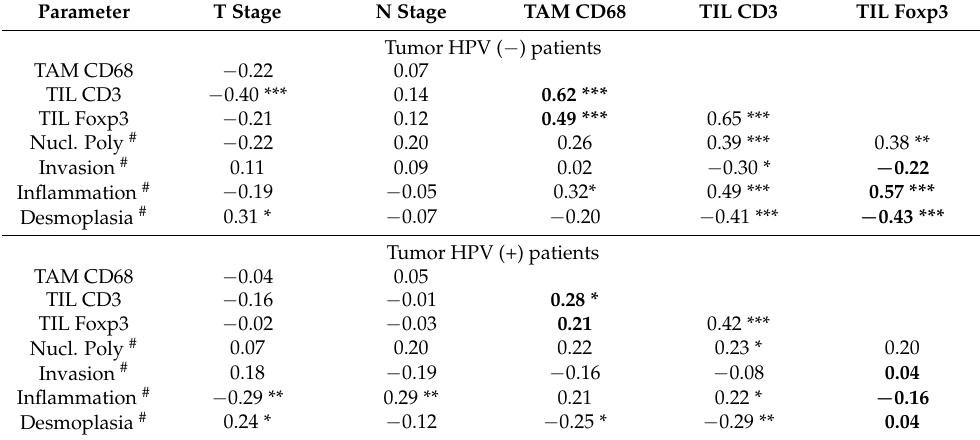
Figure 2. Cell type levels in tumors by HPV status, determined by PCR. Abbreviations: TAM: Tumor- associated macrophages (CD68 (+) cells). TIL: Tumor-infiltrating lymphocytes (CD3 (+)/Foxp3 (+) cells. These parameters determined by immunohistochemistry. Statistics by student t -test: CD68: p = 0.072; CD68-ln: p = 0.024. CD3: p < 0.001. Foxp3: p = 0.001. Y -axis: number of positive cells per HPF at 630x magnification in a Zeiss Axio microscope, calculating the mean number of positive cells in five neighboring fields, randomly chosen; mean ± confidence interval. Table 2. Pearson’s correlations between T and N stage, continuously measures levels of tumor epithelial CD3-, Foxp3-, and CD68-positive cells as well as HE histological malignancy grading; all by tumor HPV